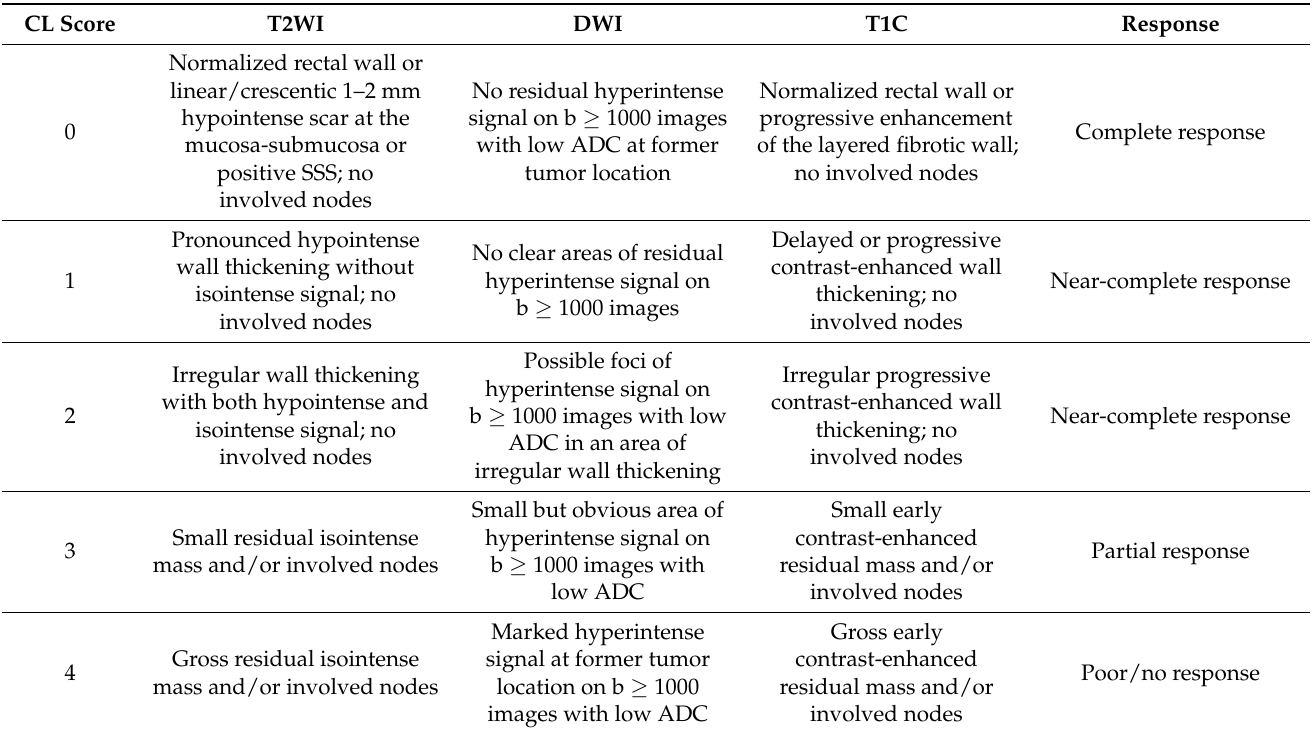
Table 2. Definitions of confidence level scores for assessment of response at tumor location and mesorectum on different MRI sequences.